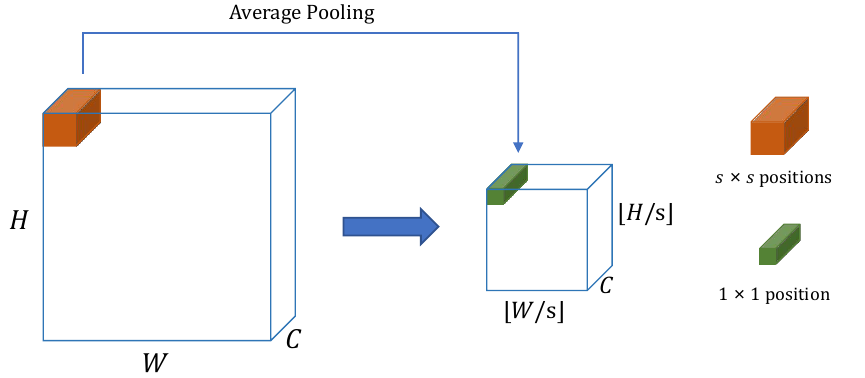
 Figure 3. An illustration of the context representation operation (better viewed in color).